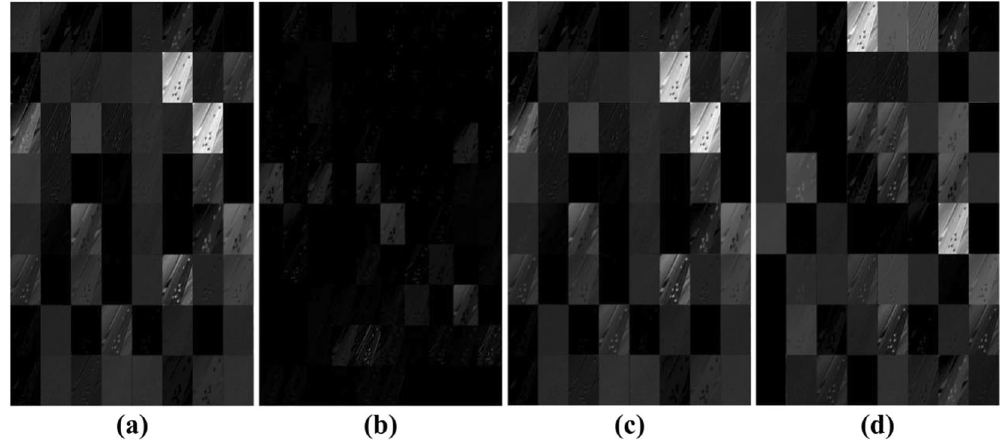
Figure 7. Visualization of the first convolutional layer using different feature extraction nets. ( a ) ZF Net; ( b ) AlexNet; ( c ) ResNet-50; ( d ) ResNet-101. Input images for this example were of the size 600 × 1000 pixels.